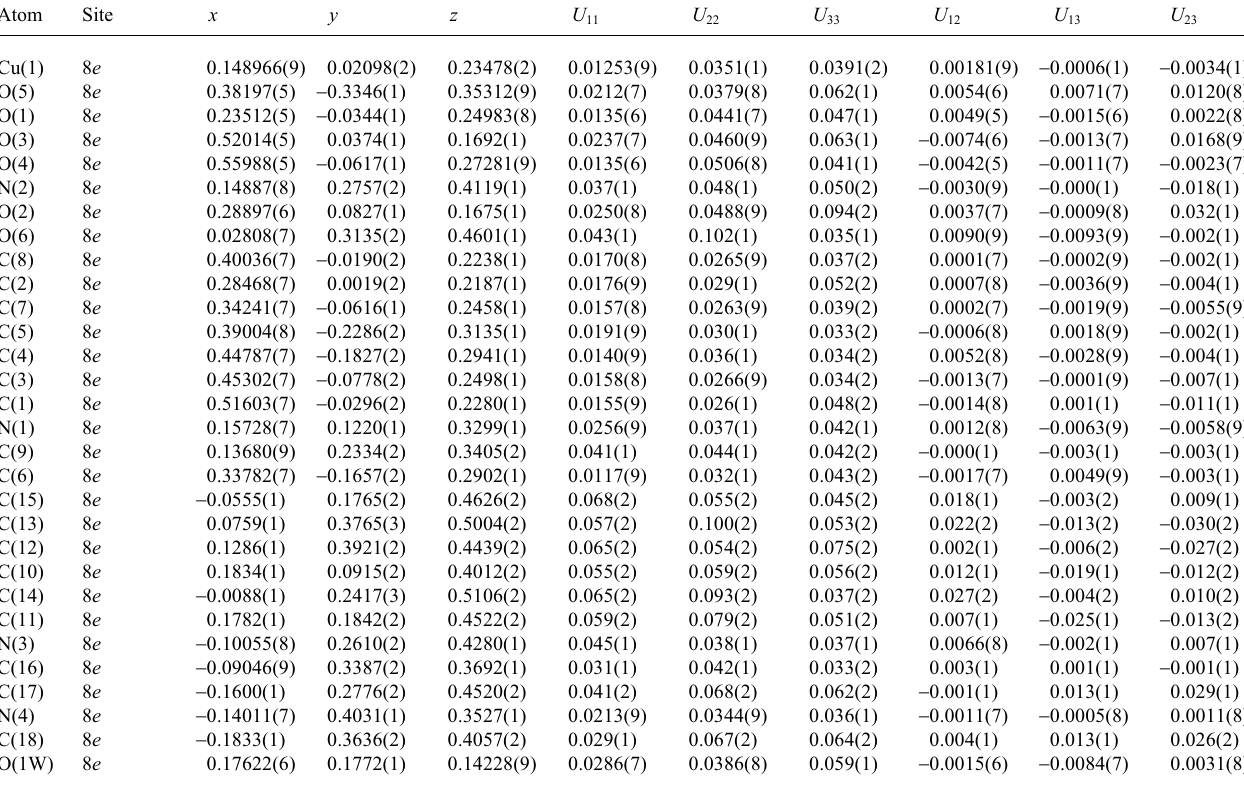
Table 3. Atomic coordinates and displacement parameters (in Å 2